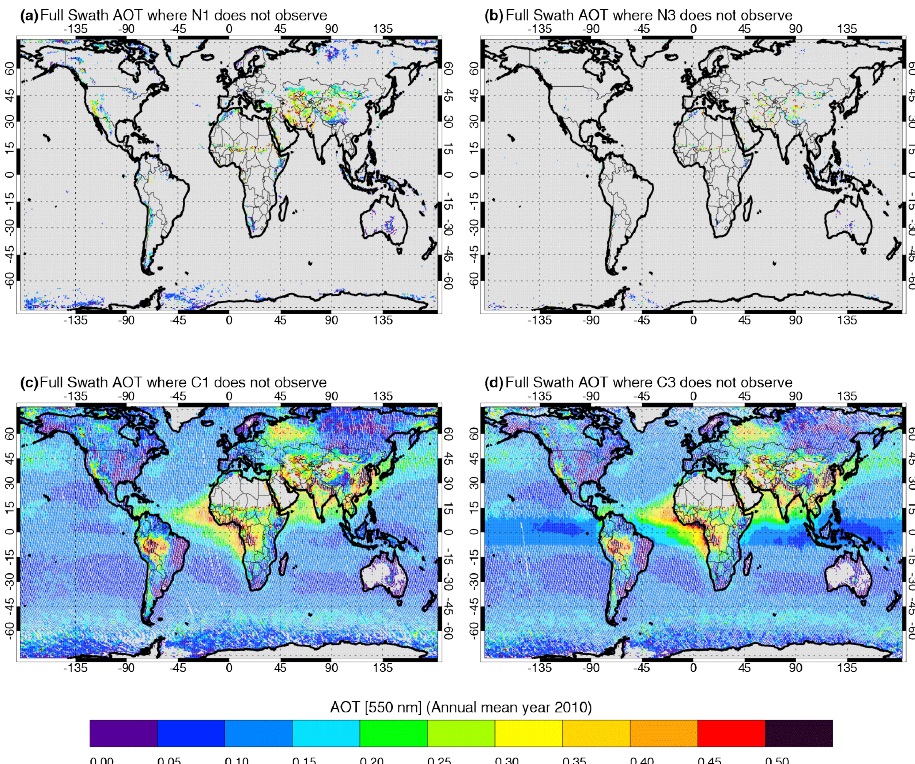
Figure 5. MODIS Aqua full swath year 2010 annual mean AOT shown only at points never sampled by the indicated sub-sample